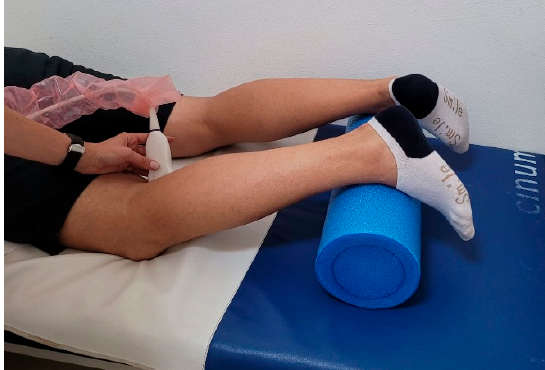
Figure 1. Patient position during ultrasound assessment.